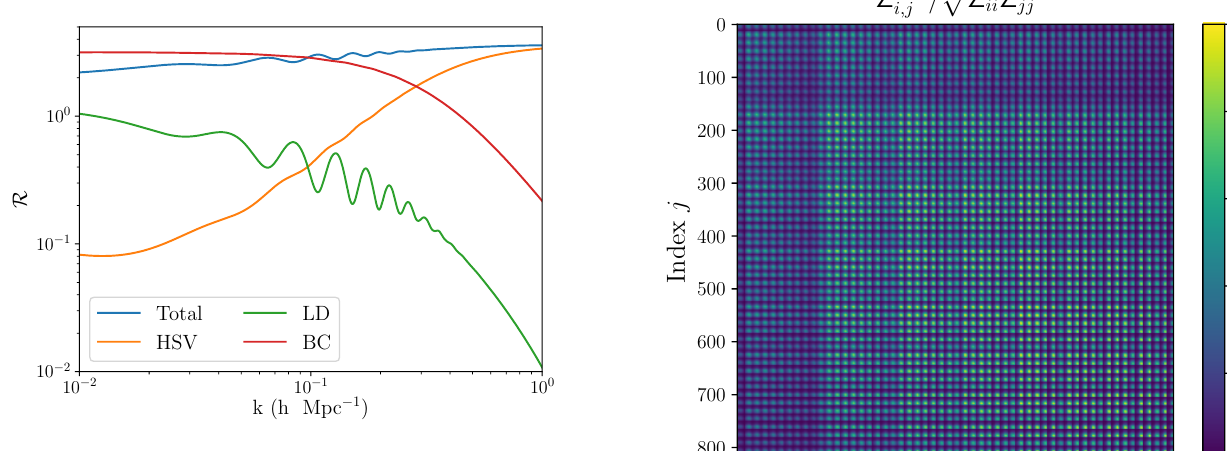
FIG. 6: Different contributions to the power spectrum re- sponse at z = 0 computed using the halo model (see Equation